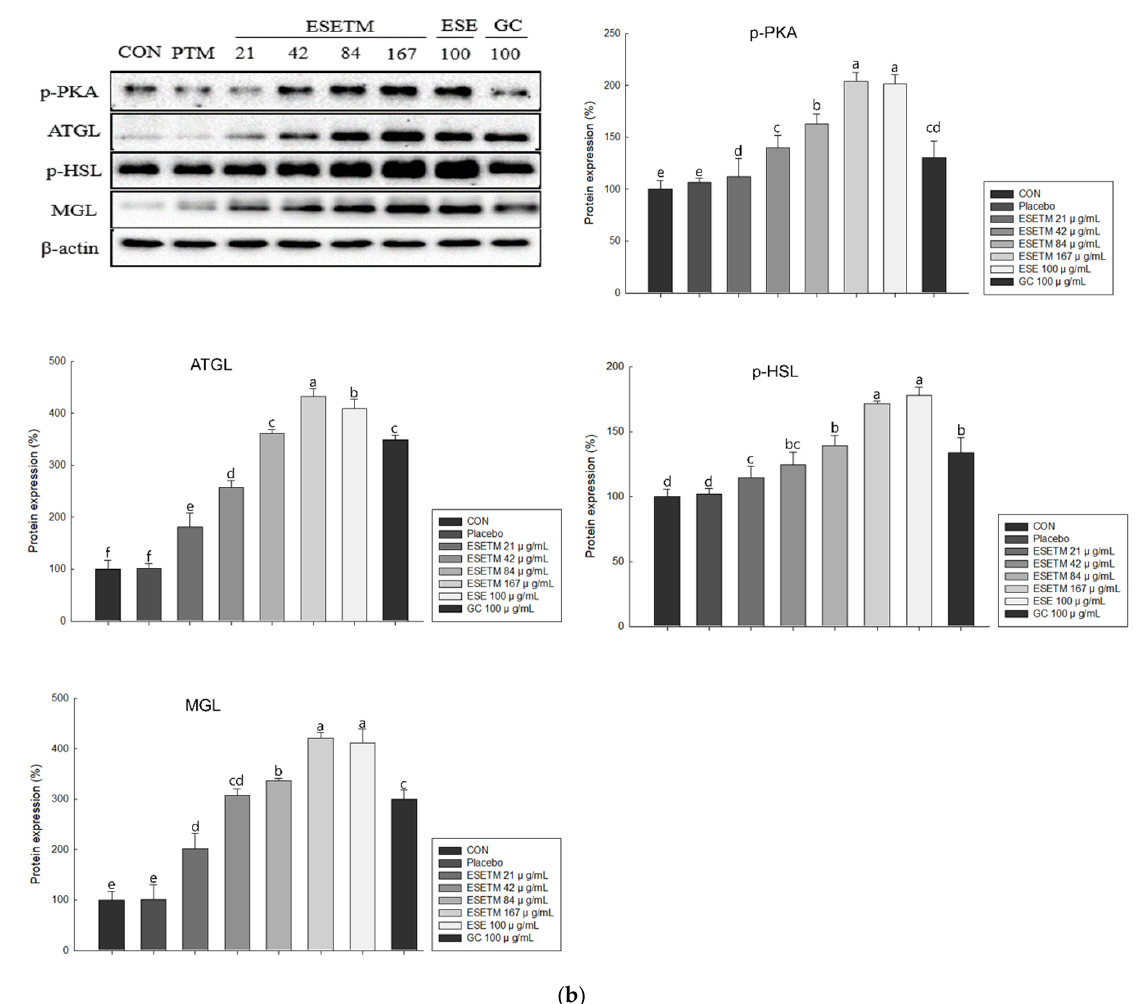
Figure 6. Effects of ESETM on lipolytic enzymes expression in ICR mice fed HFD after 7 weeks and adipocytes treated with ESETM. ( a ) Western blots of lipolytic enzymes in WAT. ( b ) Western blots of lipolytic enzymes in adipocytes. Data are shown as the means ± standard deviation (SD) ( n = 5). Different lower case letters above columns indicate statistical differences at p < 0.05.